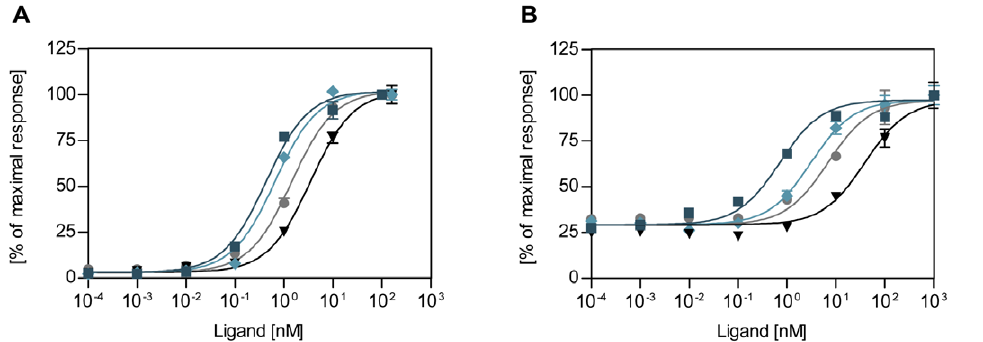
N ) or insulin analogue (B10D ( ¤ ),